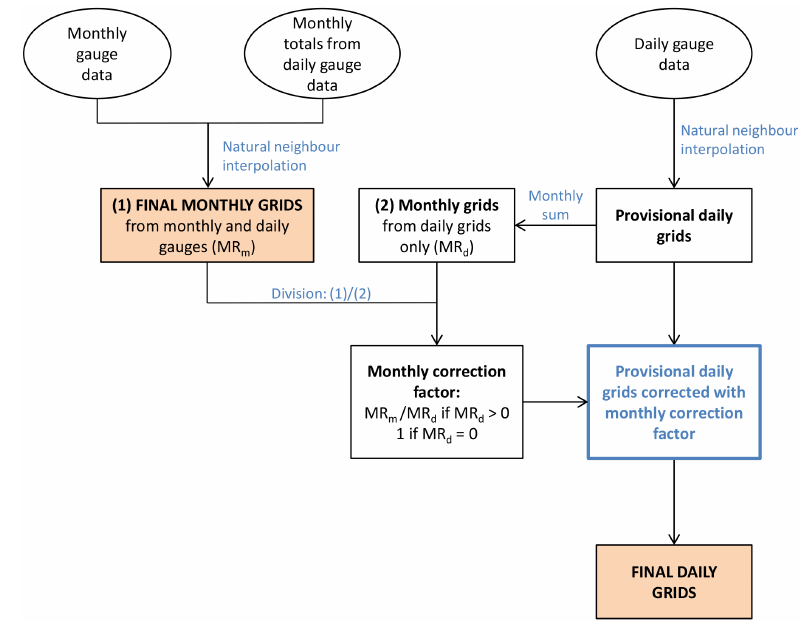
Figure 4. Schematic overview of the generation of daily and monthly 1km gridded rainfall estimates for the UK.